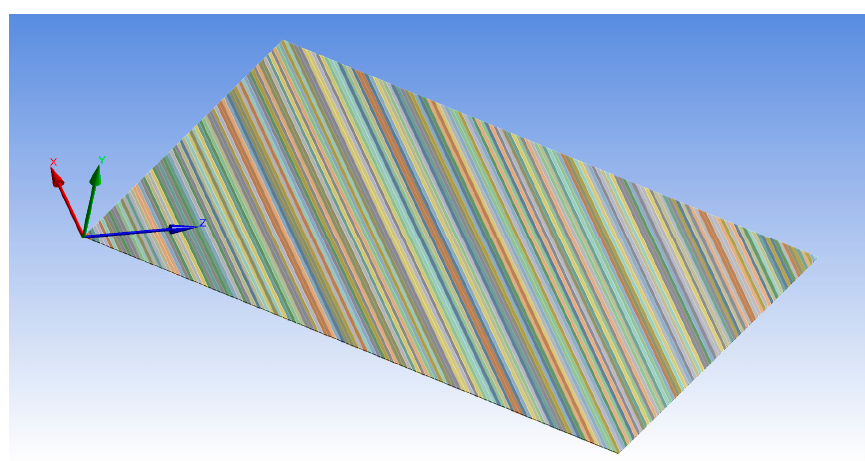
Figure 5. Detailed FE model for MFC-F1 type with 45° fibers orientation.